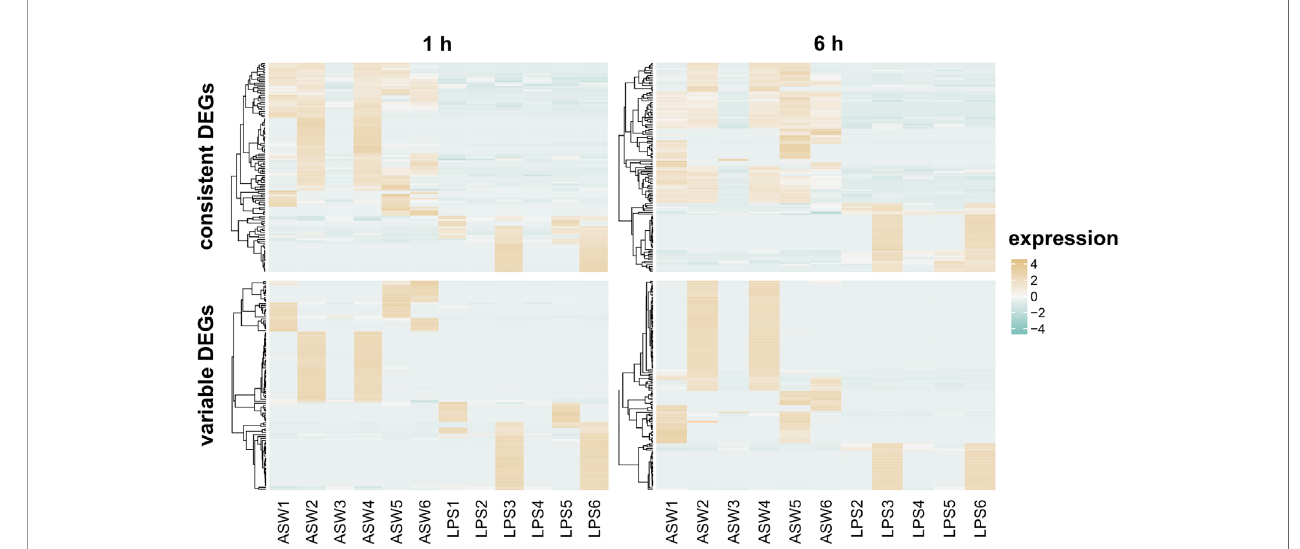
FIGURE 4 | Differentially expressed genes at 1 h and 6 h after LPS exposure. The heatmap shows the TMM-normalized relative expression per DEG (rows) for control and LPS treated samples (columns). DEGs are divided according to expression pattern in consistent and variable expressed (see Methods ). Genes were de fi ned as differentially expressed with FDR p-value < 0.005 and log2|FC| ≥